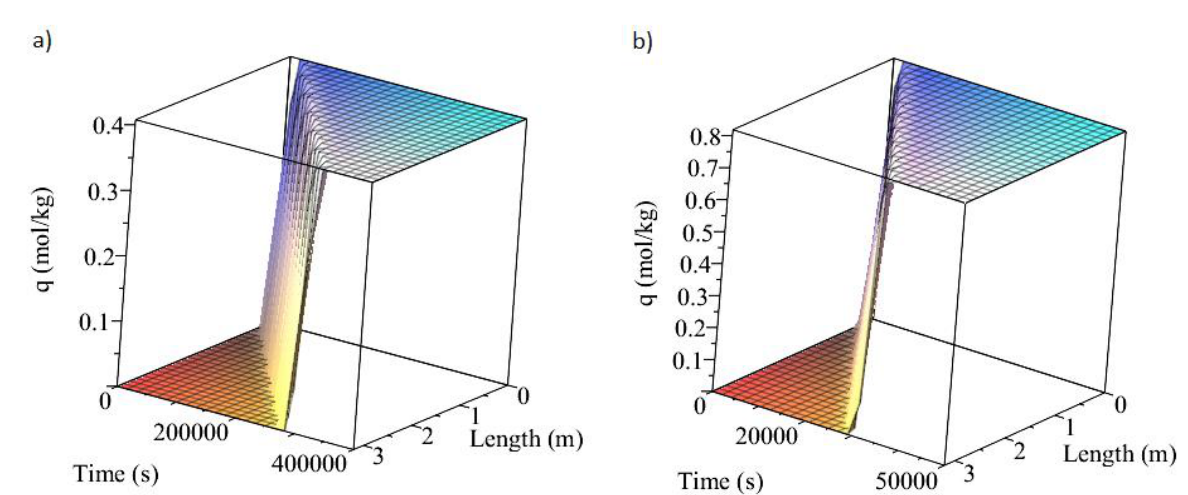
Figure 6 . Loading for chemisorbents: ( a ) SI-AEATPMS sorbent and ( b ) APDES-NFC-FD sorbent